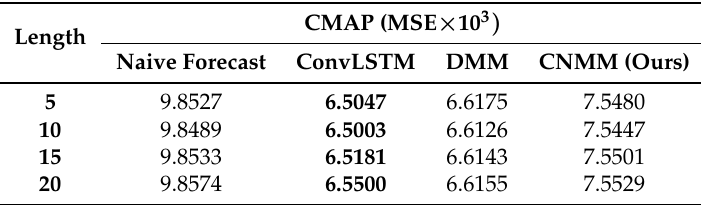
Table 6. Forecast MSE of the CMAP data experiment on each model. The length here shows in how many timesteps the forecast is done on each model. The bold numbers indicate the lowest error achieved on each forecast